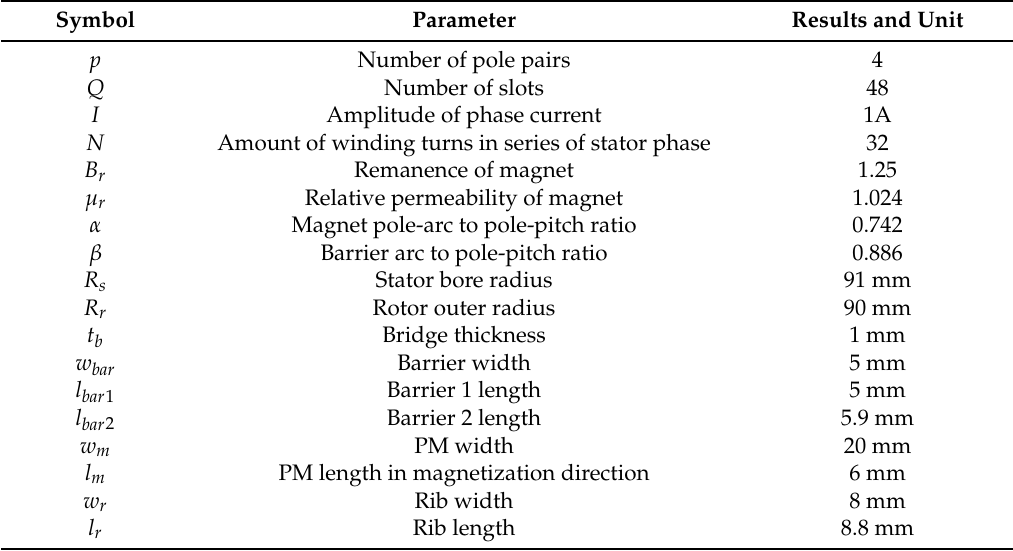
Table 1. Main parameters of the 8-pole/48-slot motor.